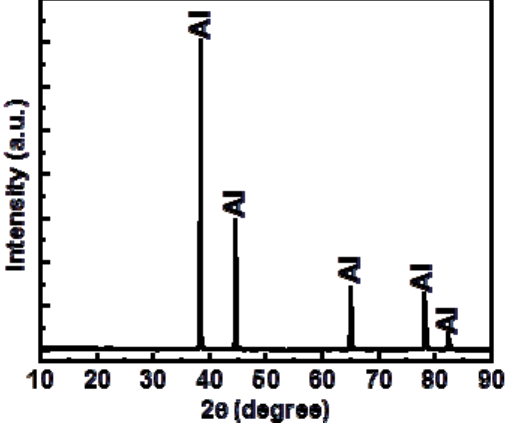
Figure 4. The XRD of aluminum coating using the arc thermal metal spray process.